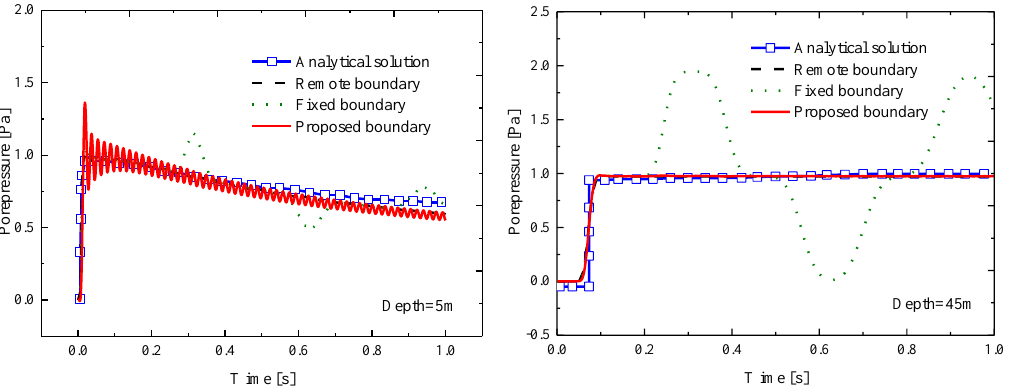
Figure 3. Vertical displacement and pore pressure time histories of one-dimensional saturated soil model.